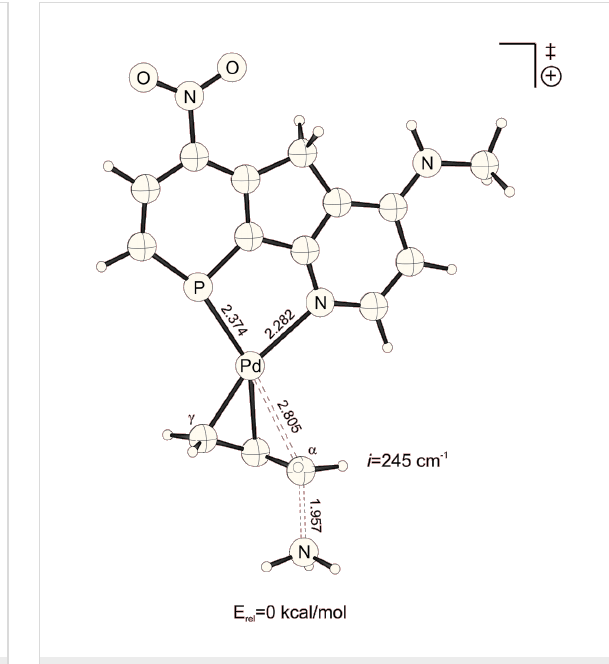
Figure 5: Transition structure for the energetically favored trans to phosphorus addition of ammonia at the Pd-η 3 -allylic intermediate